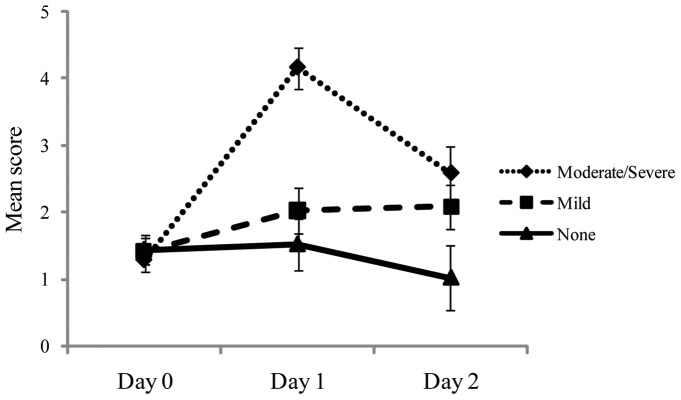
Experiment 3: Mean symptom ratings for the three seasickness severity groups as a function of days.The error bars represent standard error of the mean.